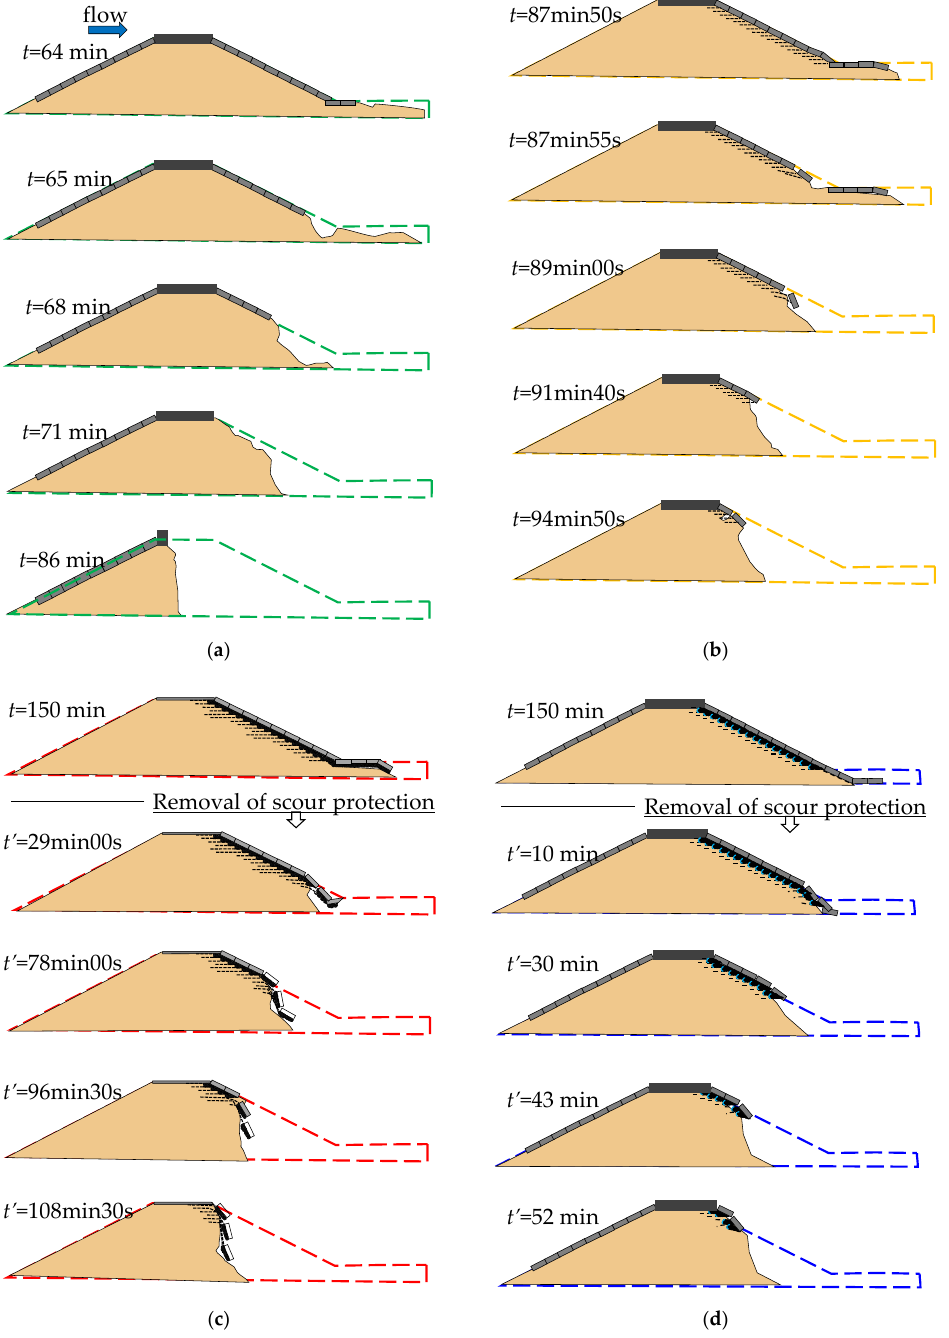
Figure 7. Temporal variations of levee failures in ( a ) Case A, ( b ) Case B, ( c ) Case C, and ( d ) Case D. In Case B (GRS levee), in which the geogrid was laid in the levee and connected to the concrete panels, the residual rates for the cross-sectional area maintained 100% until about t = 87 min. However, at t = 87 min 50 s, the concrete panels of Nos. 1 and 2 expanded downward and, 5 s later, were flowed out. After that, the concrete panels on the back slope gradually flowed out from the bottom. Since the concrete panels were connected to the geogrid, the concrete panels resisted to some extent, even after displacement. At t = 94 min 50 s, the concrete panels of No. 7 flowed out, and the concrete panels of Nos. 8 and 9 also began to be displaced. At t = 95 min 04 s, all concrete panels on the back slope